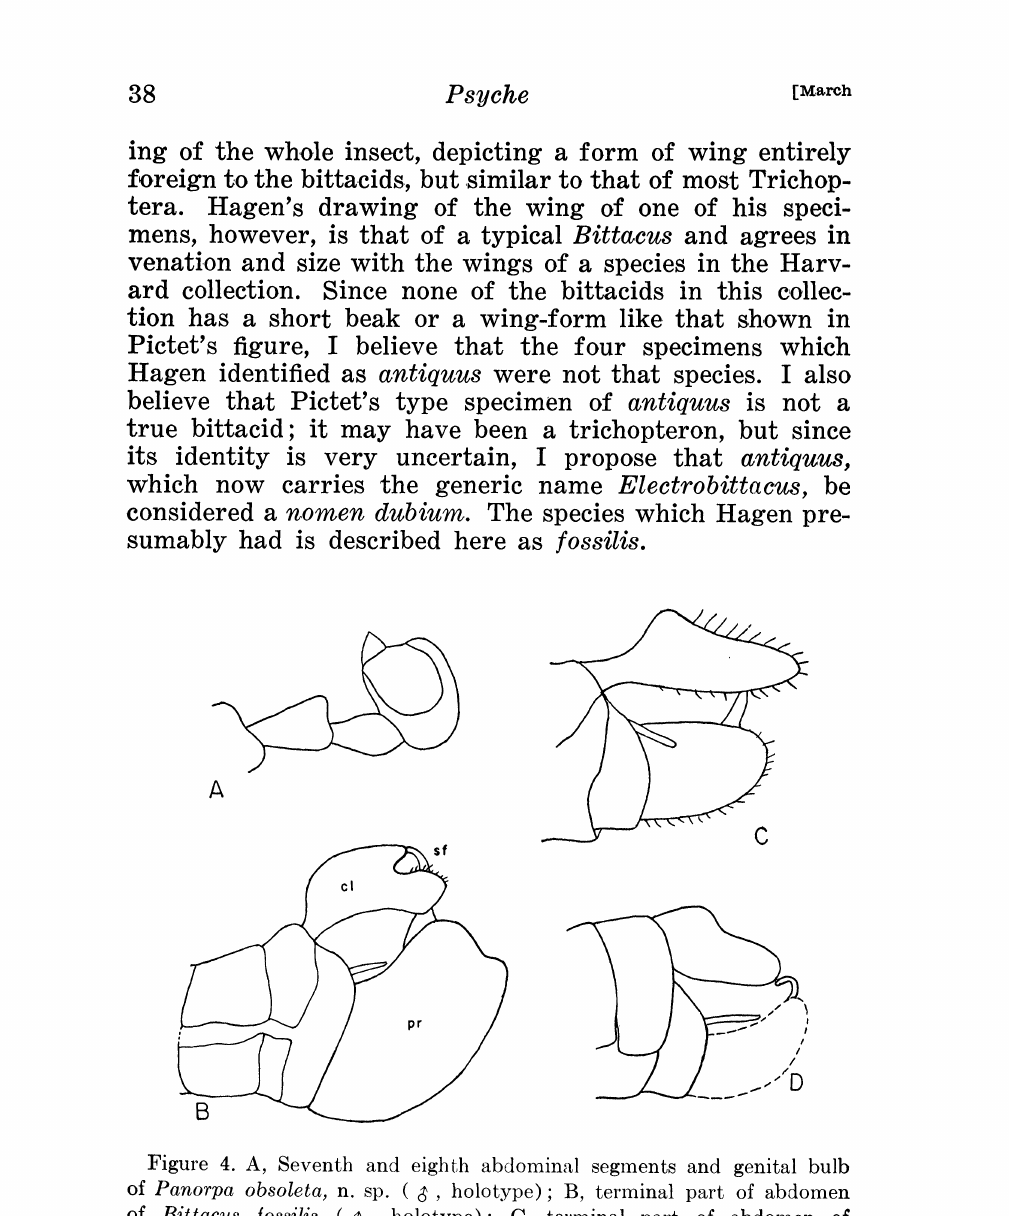
Figure 4. A, Seventh and eighth abdominal segments and genital bulb of Panorpa obsoleta, n. sp. 6, holotype); B, terminal part of abdomen of Bittacus ]ossilis (6, holotype); C, terminal part of abdomen of Bittacus succinus, n. sp. (6, holotype); D, terminal part of abdomen of Bittacus minirnus, n. sp. 6,